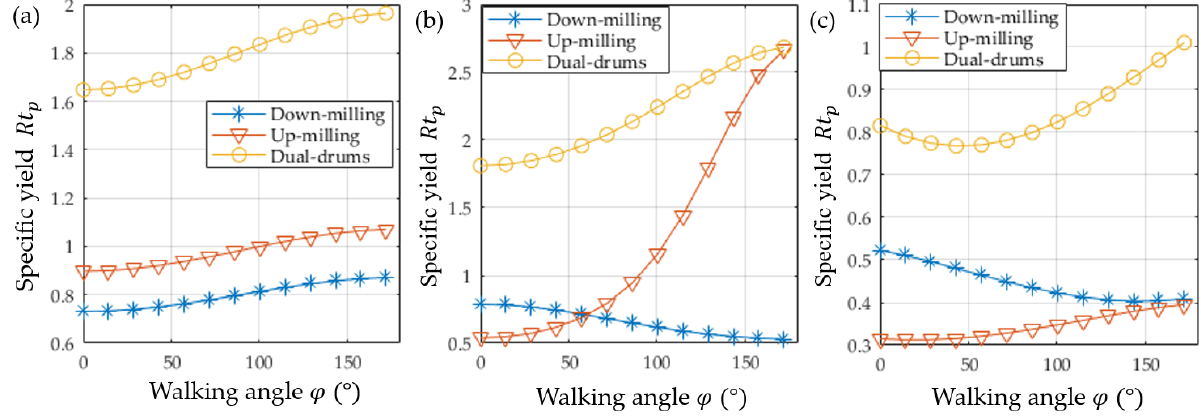
16 of 28 Table 4. Parameters for the stability analysis. Parameters